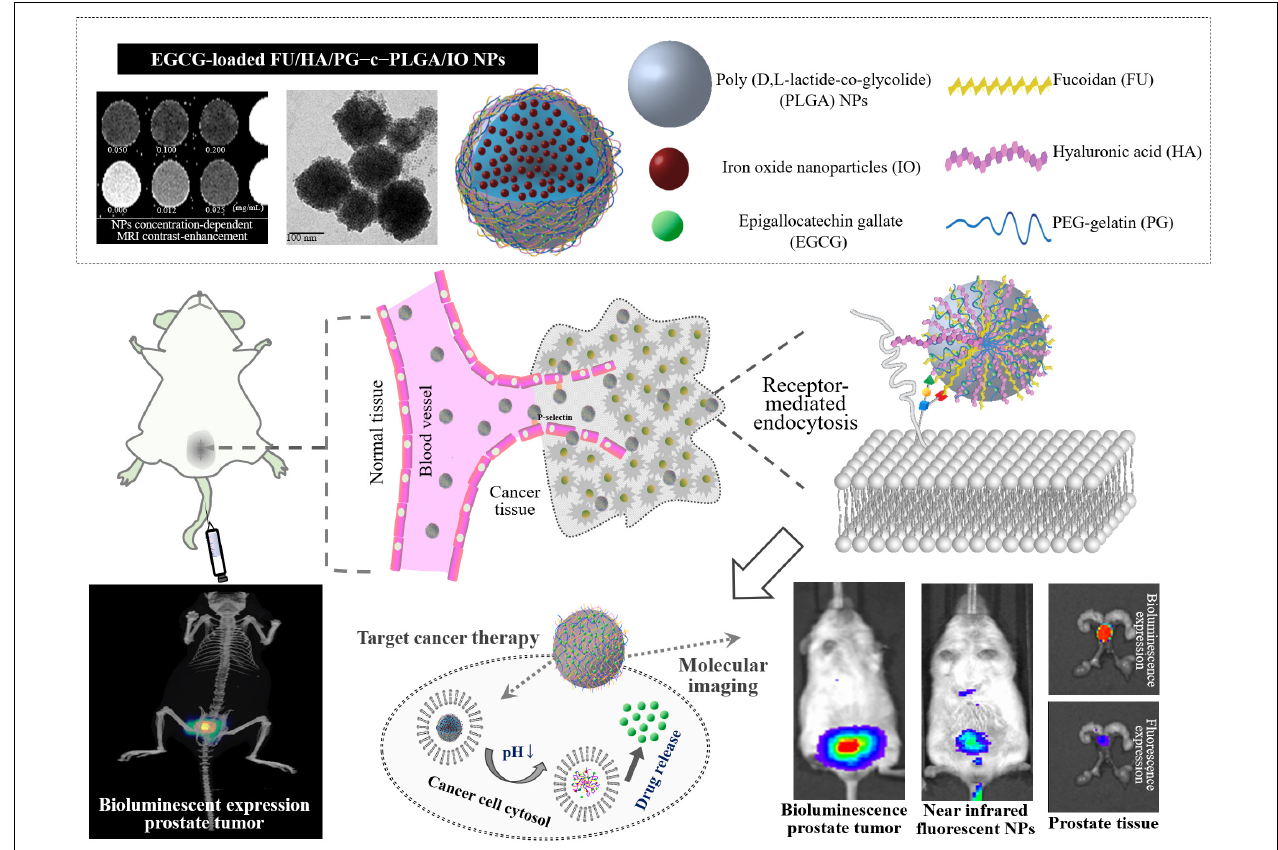
FIGURE 1 | Schematic representation of using an effective epigallocatechin gallate (EGCG)-loaded FU/HA/PG-coated [Poly (D,L-lactide-co-glycolide); PLGA] nanoparticles (NPs) targeting strategy and observation of their putative effects on prostate carcinoma cells.